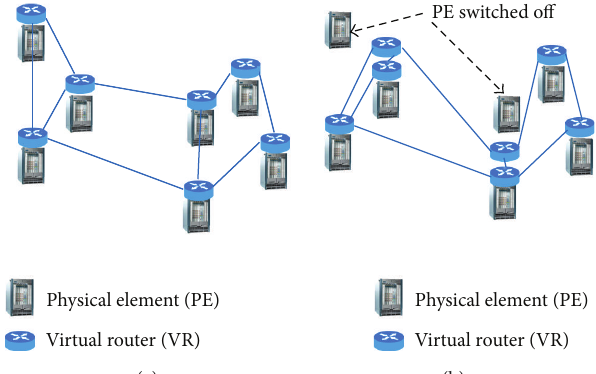
Figure 1: An example of virtual router migration for reducing the power consumption in Internet. The network is composed of seven physical elements (PE) and seven virtual routers (VR) (a). Two VRs migrated and two PEs can be switched off (b).